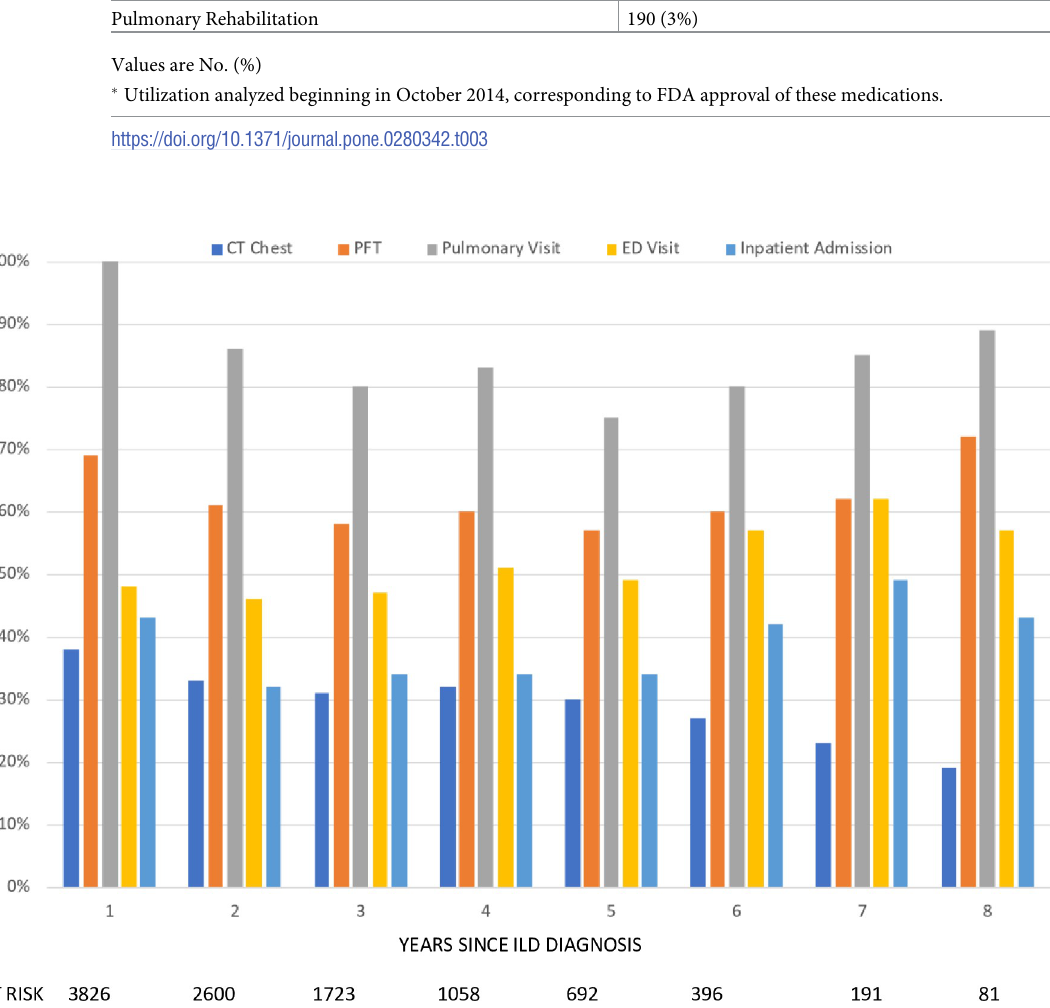
Fig 2. Longitudinal health care resource utilization in ILD. Annual percentages of health care utilization for patients with ILD post-diagnosis. PFT = pulmonary function test; ED = emergency department.